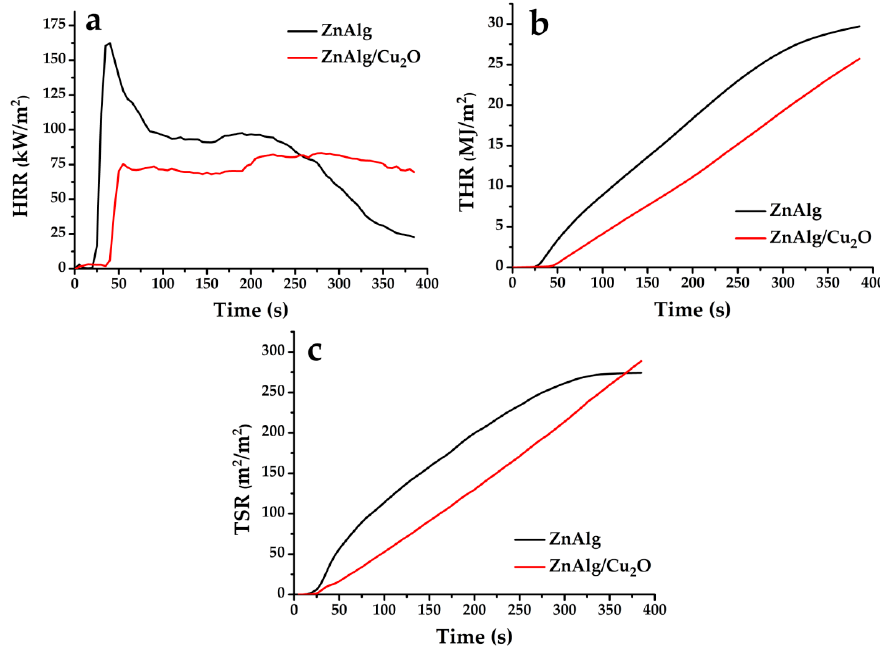
Figure 5. ( a ) HRR, ( b ) THR and ( c ) TSR curves of ZnAlg and ZnAlg/Cu 2 O changing with